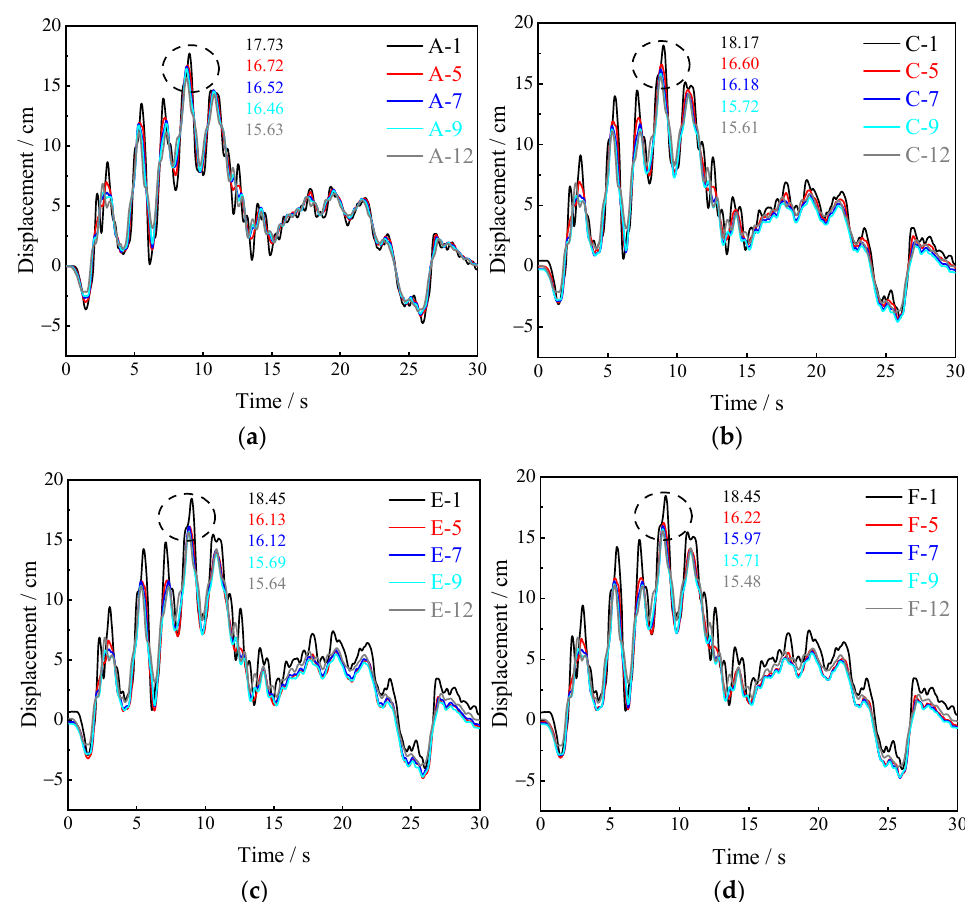
Figure 12. Relative horizontal displacement of monitoring points under seismic excitation: ( a ) monitoring point A, ( b ) monitoring point C, ( c ) monitoring point E and ( d ) monitoring point F. Figure 13 shows the vertical displacement of the number one, number two, number five and number six pilot tunnels’ vault and bottom with time. As depicted in the above figure, when under horizontal seismic excitation, the horizontal acceleration also pro- duces displacement components in the vertical direction. At 0~15 s, the vertical displace- ment of pilot tunnels at the top and bottom fluctuates in a certain range due to the large acceleration amplitude; at 15~30 s, this fluctuation tends to disappear, and the vertical displacement changes approximately linearly with time. The displacement changes of the monitoring points at the top and bottom of pilot tunnels show that their relative displace- ments remain nearly unchanged, suggesting that the vertical displacement response of the pilot tunnels and the neighboring soil is nearly the same.